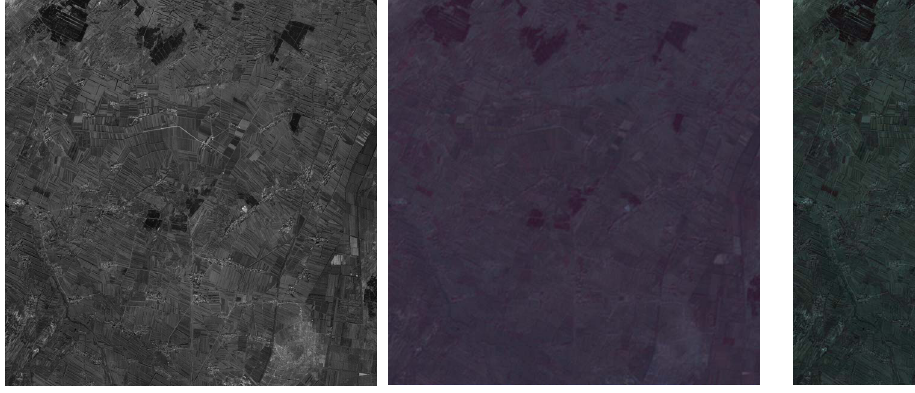
Figure 6. The multispectral image of Beijing-1 small satellite(M2)